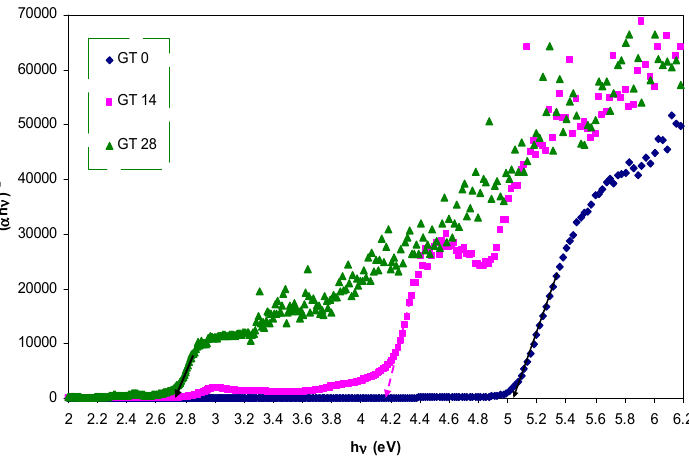
Figure 8. The plots of ( α h υ ) 2 vs. ( h υ ) for all the samples.